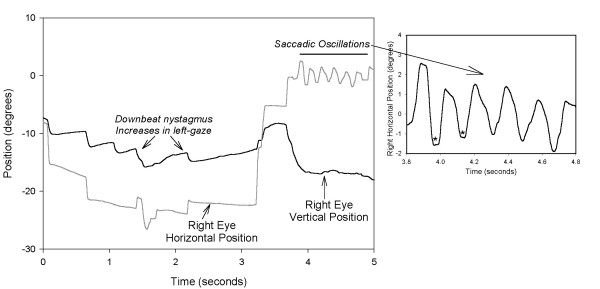
Representative record from Patient 2, showing downbeat nystagmus on left-gaze and a burst of horizontal saccadic oscillations. On the inset at right, the saccadic oscillations are shown at a different time scale; note that an intersaccadic interval (marked by asterisk) is present for some, but not all, cycles. Same conventions as in Figure 1.